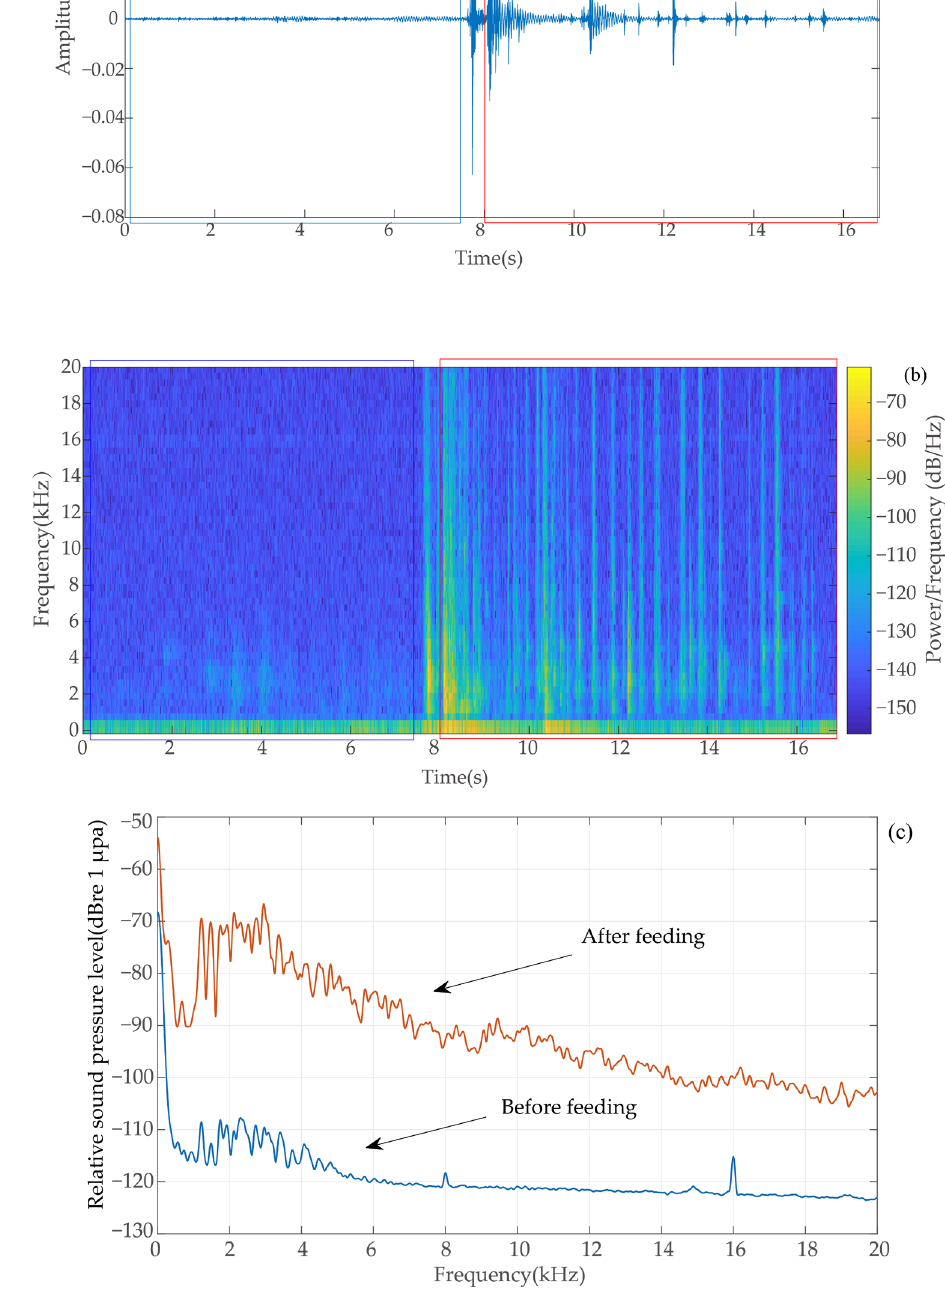
Figure 1. Comparison of waveform ( a ), spectrograms ( b ), and relative sound pressure ( c ) before and after feeding (unreduced noise).